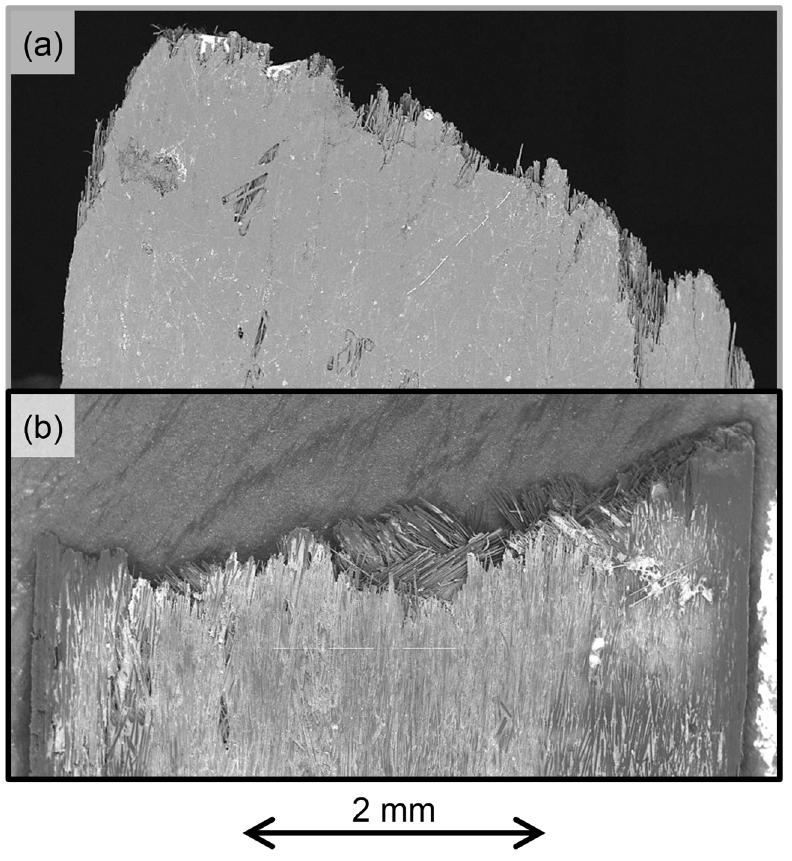
Figure 9. Failure surface SEM images: ( a ) UD; ( b ) QI.